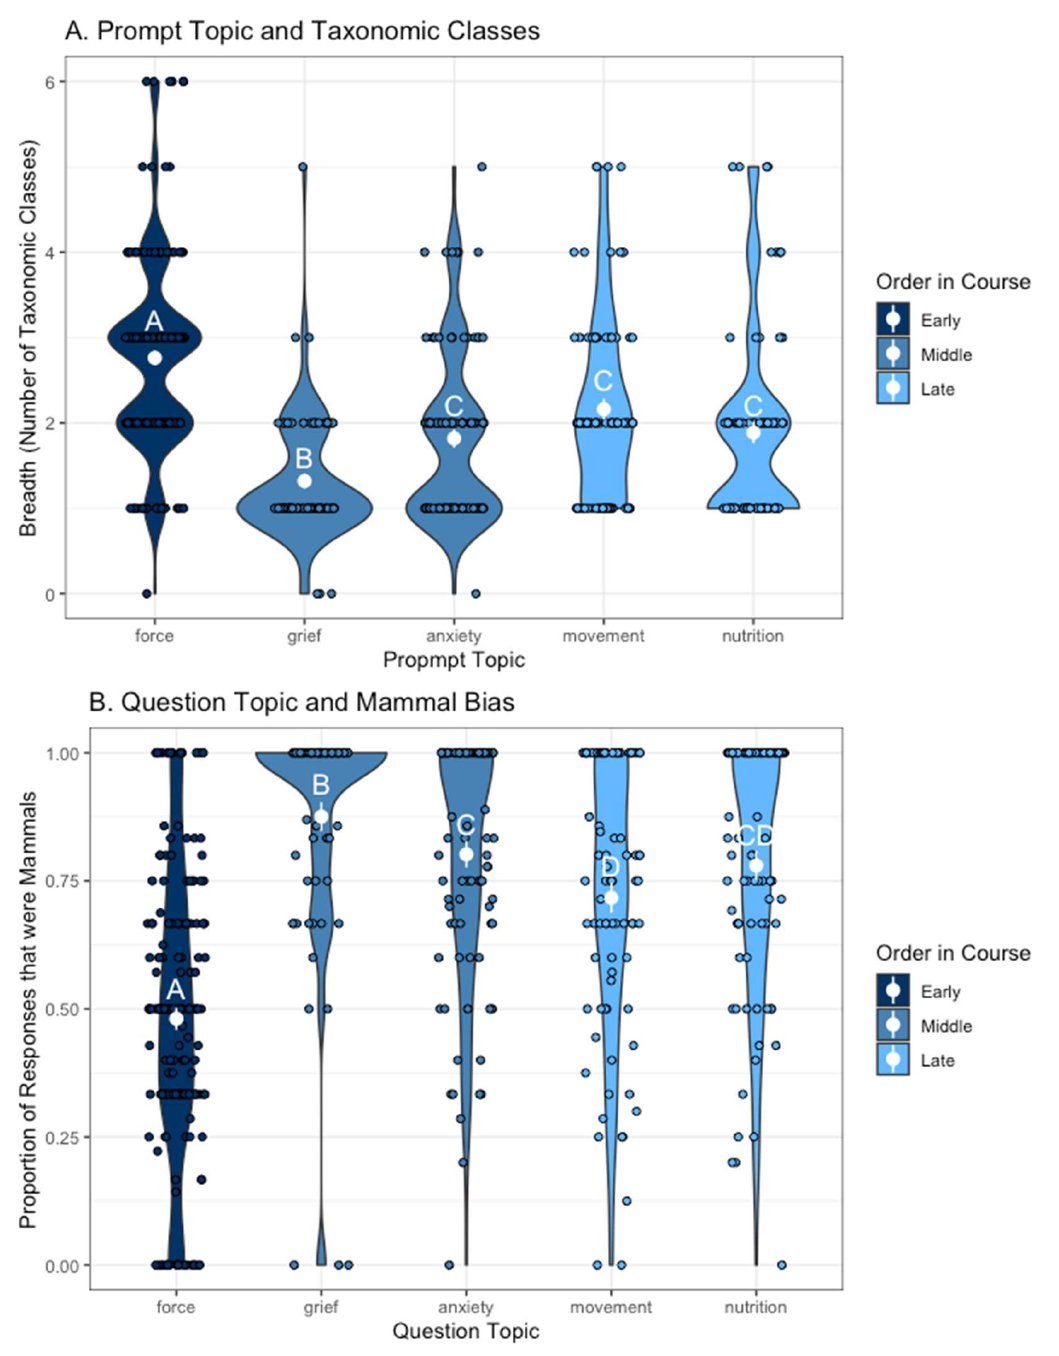
Figure 1. Violin plots illustrating the relationship between the prompt topic and ( A ) the number of taxonomic classes represented (breadth) in the list of examples given by each student and ( B ) the proportion of examples that were mammals (mammal bias). Figures were made with raw data, and analyses presented in the text include student as a random effect (n = 492). “Force” had greater breadth (number of taxonomic classes represented) and less mammal bias (proportion of examples that were mammals) compared to other prompt topics. “Grief” had the least taxonomic breadth and the most mammal bias, while anxiety, movement, and nutrition were intermediate for both these measures of divergent thinking. The temporal order these prompts came in the course is represented by color (e.g., grief and anxiety were assigned the same week) and appeared to have less of an effect on student responses compared to the topic of the prompt. Letters on the graph denote significant differences using pairwise t -tests ( p < 0.05); raw data are shown as jittered points.